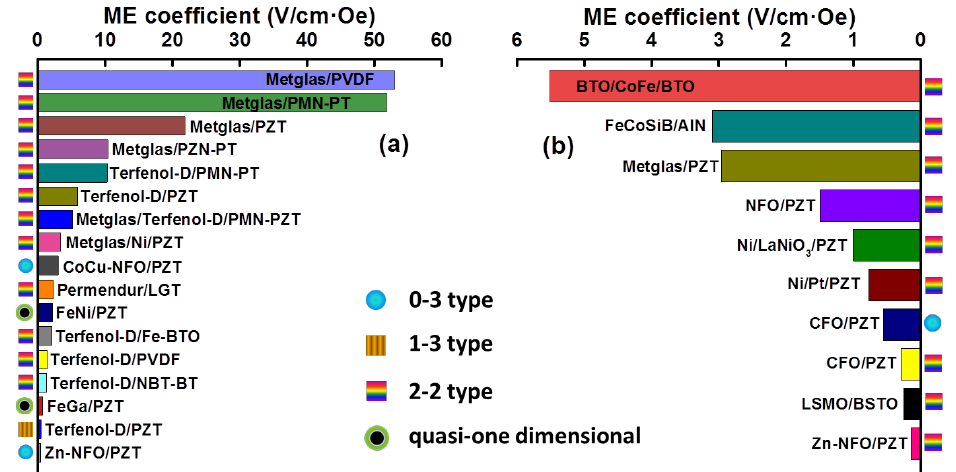
Figure 8. Reported values of off-resonance ME voltage coefficients for various material systems: ( a ) bulk and ( b ) film-based ME composites. Data taken are from Ref.